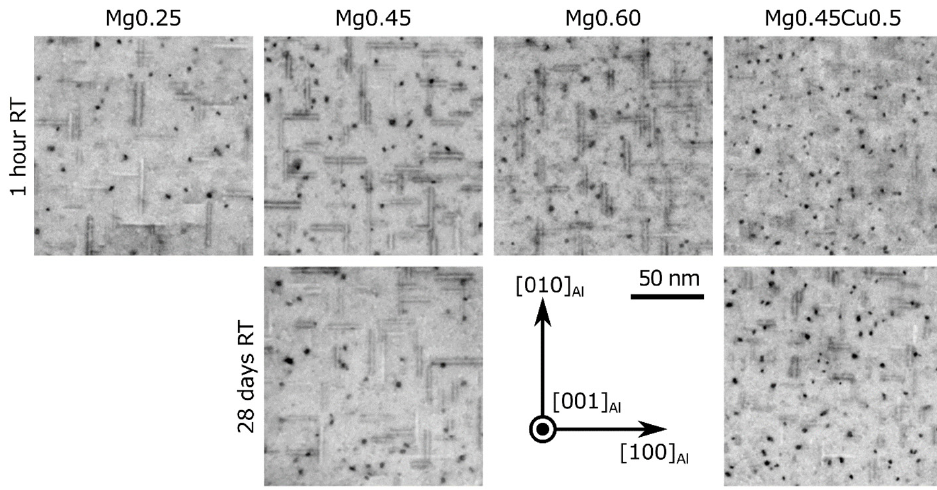
Figure 6. Inverted LAADF-STEM images of all 6 investigated peak hardness conditions (5 h at 175 °C).